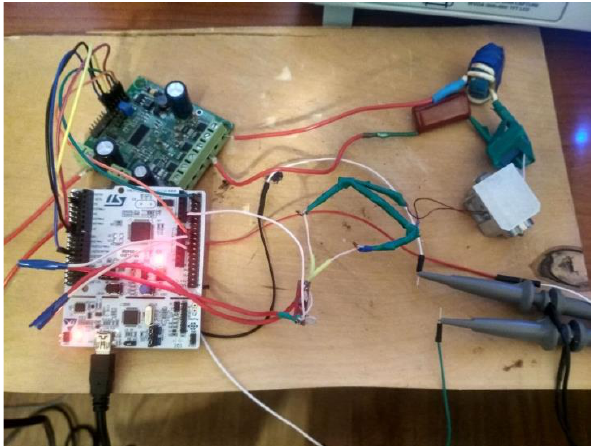
Figure 3. Appearance of the testbed